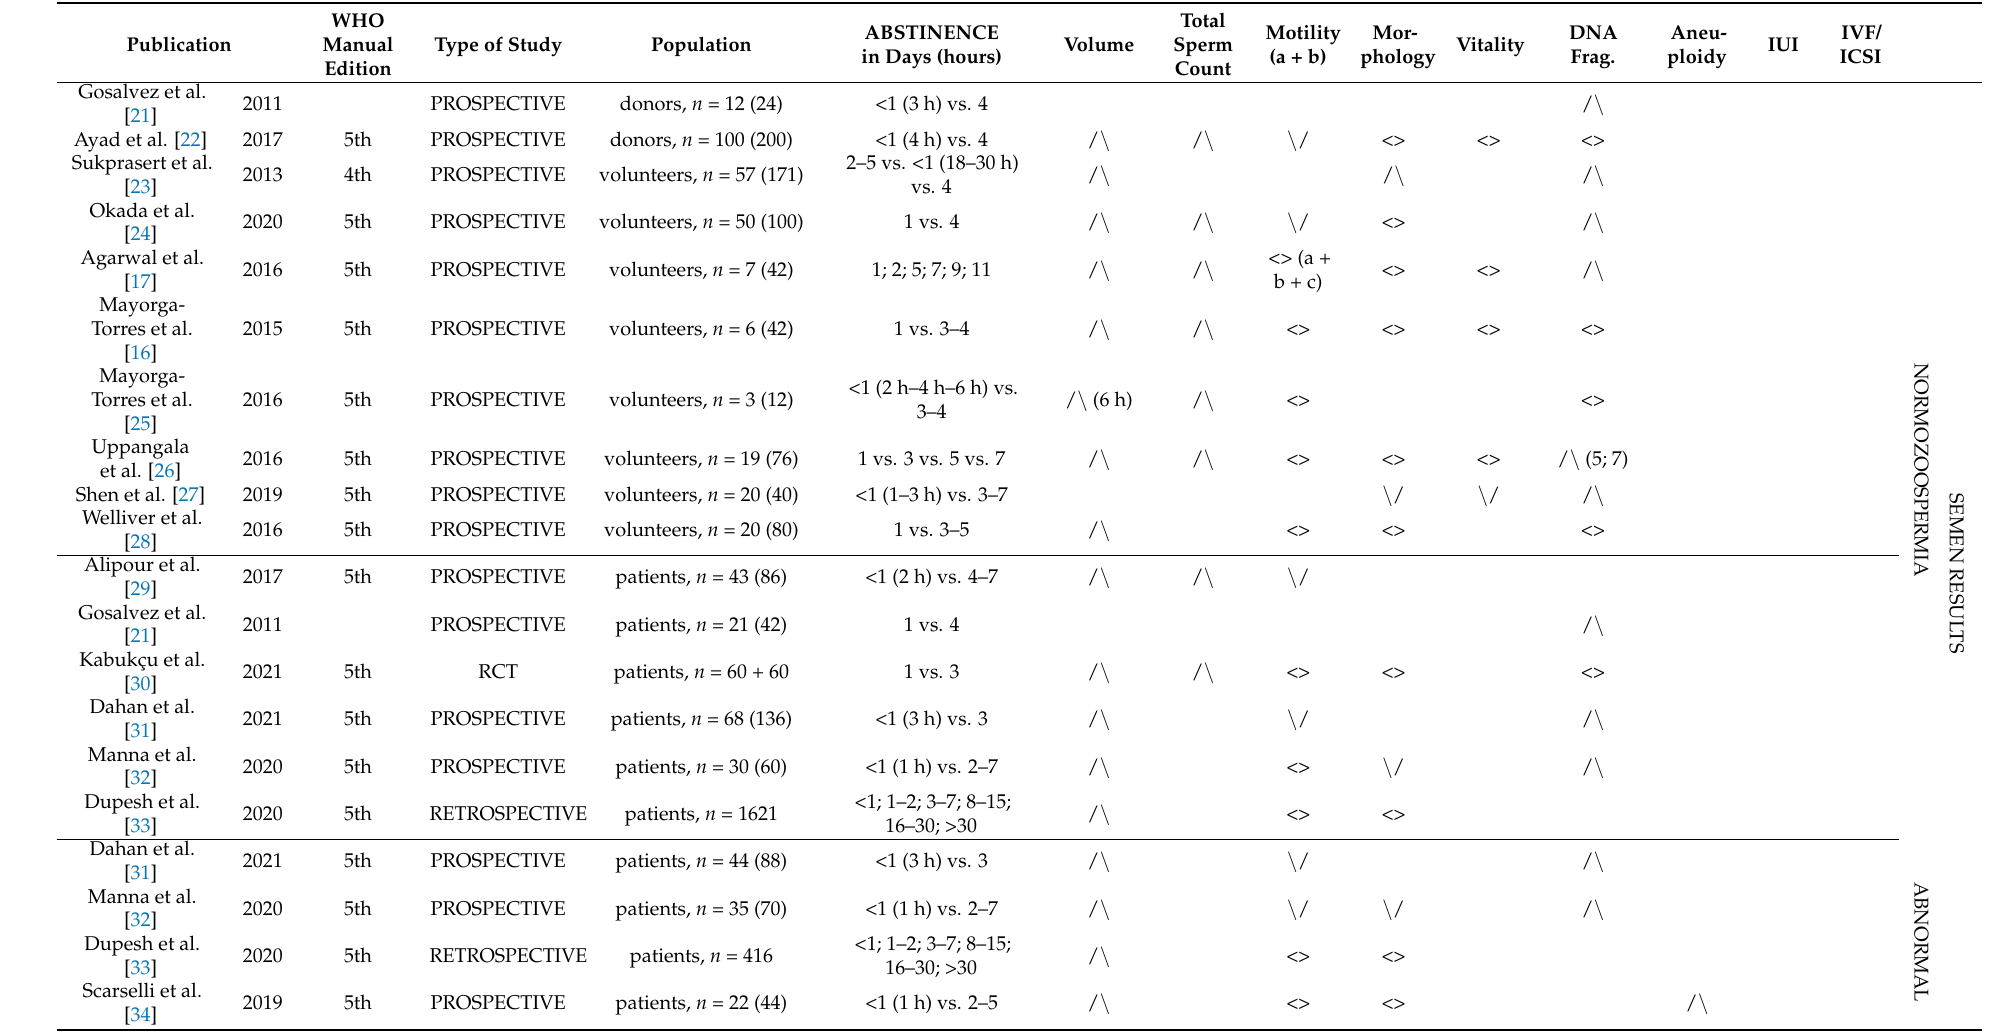
Table 1. Details from included studies regarding ejaculatory abstinence period, semen parameters and clinical